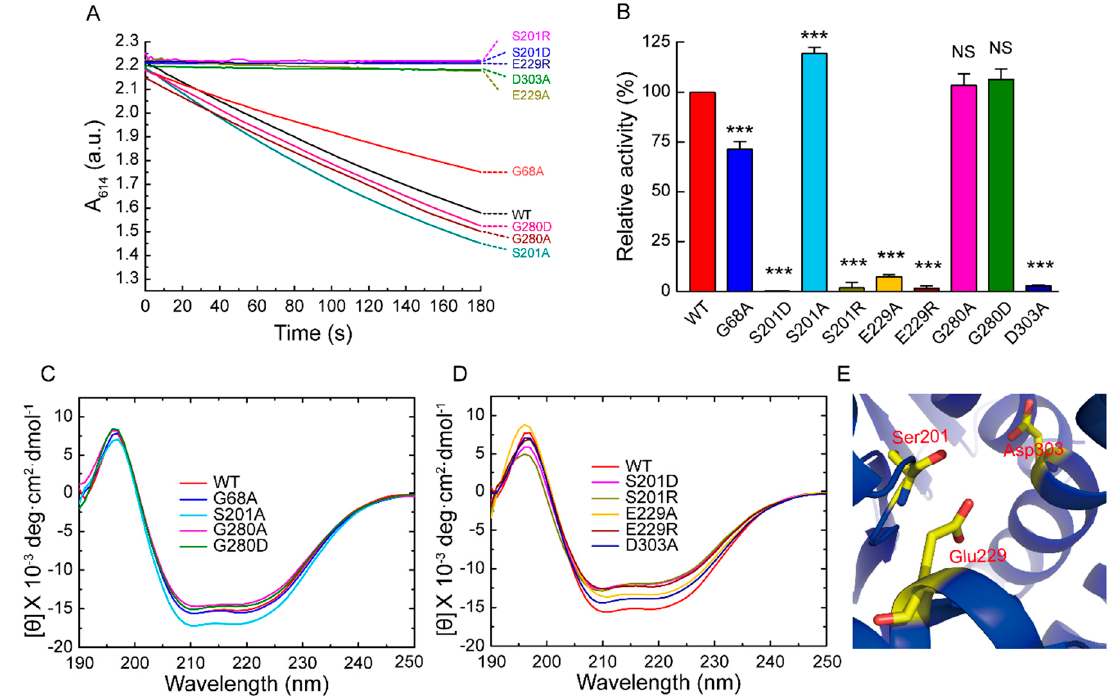
Figure 3. Influence of mutations on BmADK activity and secondary structure. ( A ) Determination of enzymatic activity of BmADK mutants and WT. ( B ) Comparison of enzymatic activity between BmADK mutants and WT. All experiments were performed in triplicate. Data are represented as mean ± SD. ***, p < 0.001, compared to the control. ( C , D ) CD spectra of BmADK and its mutants. The mean residue ellipticity was the arithmetic mean of three independent tests. ( E ) Homologous modeling of the substrate-binding pocket of BmADK. The catalytic residues (S201, E229, D303) are shown in sticks.